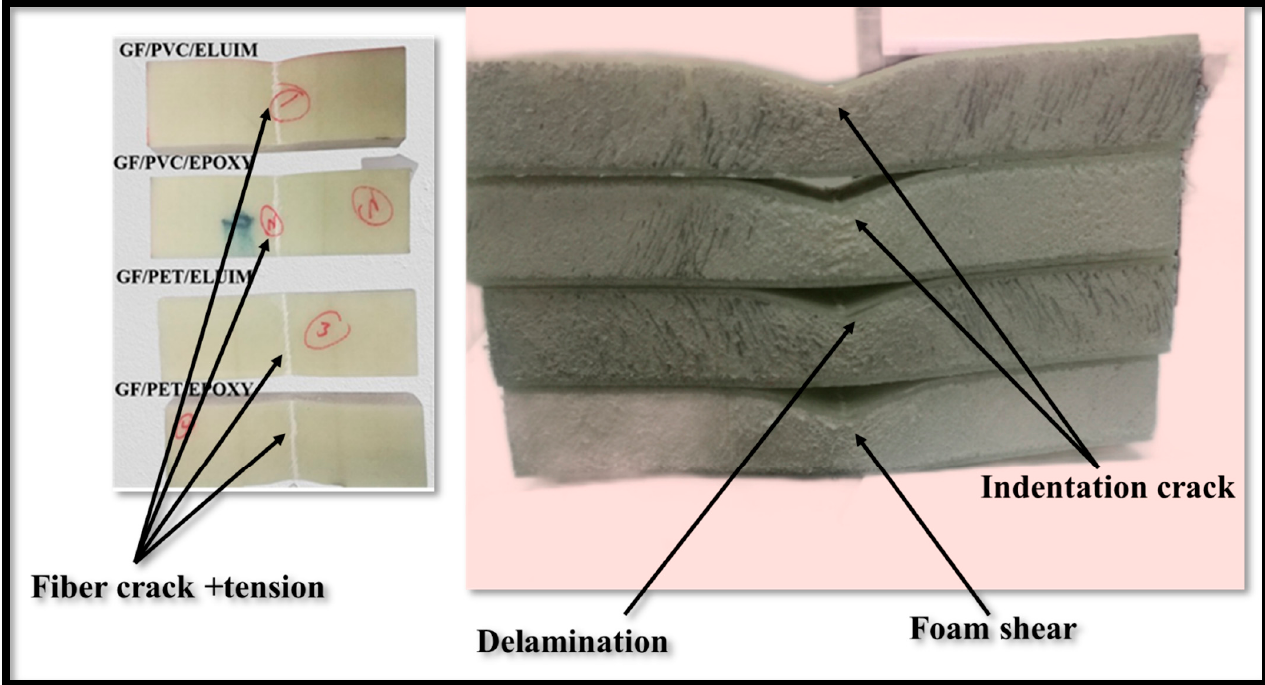
Table 3. Flexural test results of sandwich GFRP composites.